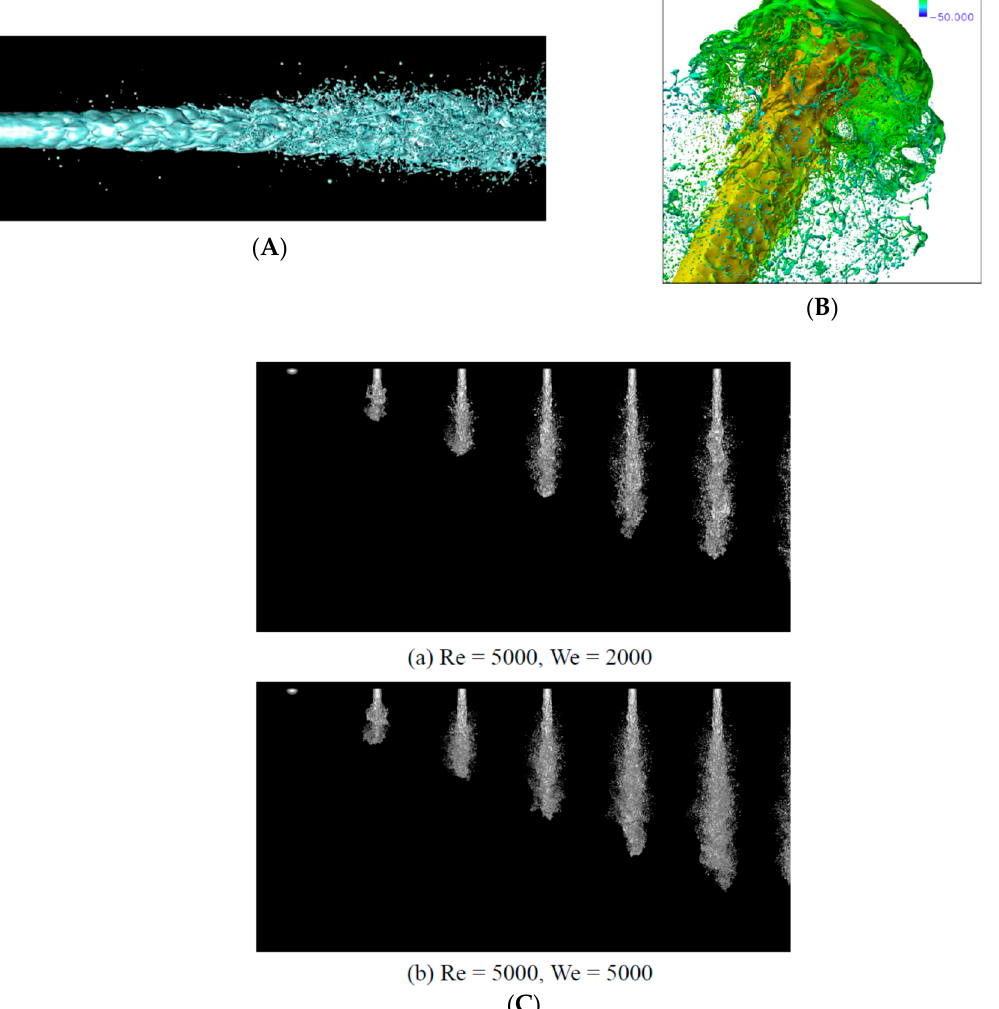
Figure 6. Examples of direct numerical simulation (DNS) in a straight jet configuration. ( A ) Turbulent jet spray by Menard et al. [44] with nozzle diameter D nozzle = 0.1 mm and injection velocity U inj = 100 m/s; ( B ) Head deformation and atomization for a jet spray by Shinjo and Umemura [23] with nozzle diameter D nozzle = 0.1 mm and injection velocity U inj = 100 m/s. Reproduced with permission from Elsevier; ( C ) Temporal development of turbulent spray [51]. Re and We are based on liquid values.